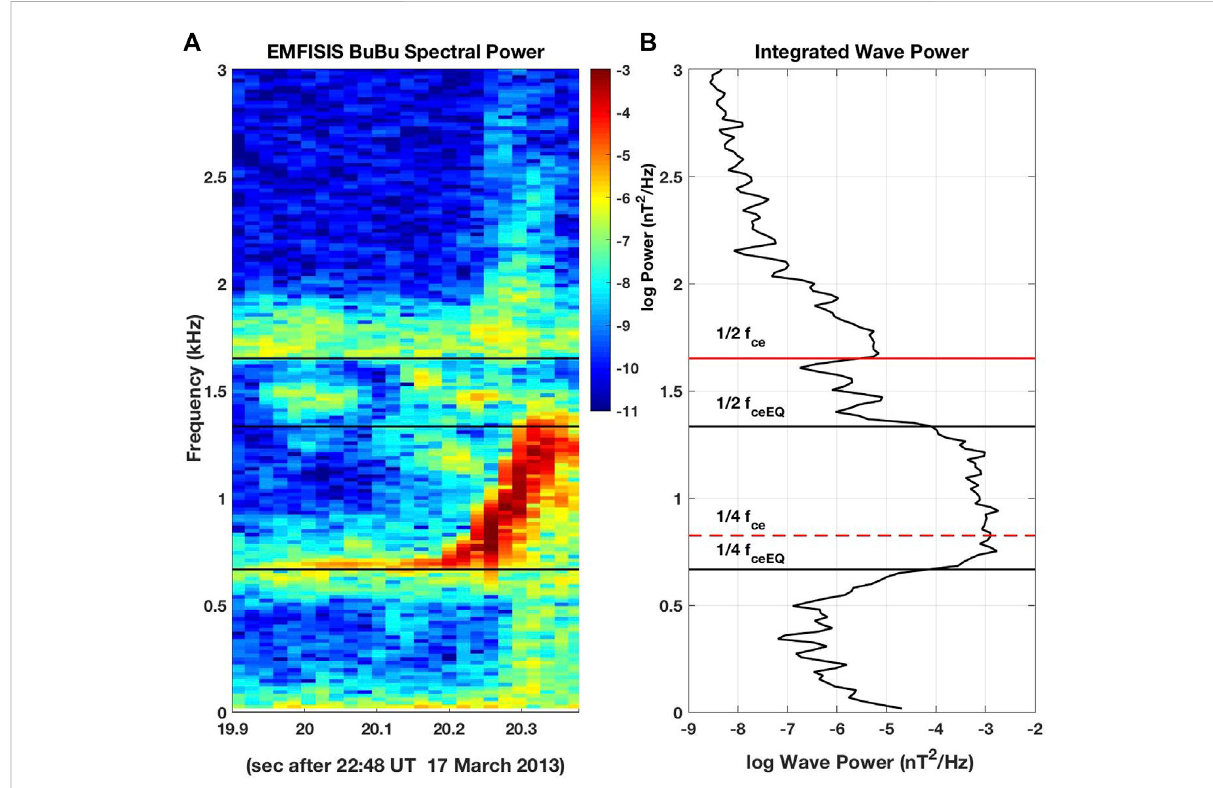
FIGURE 8 (A) The magnetic fi eld spectrogram observed near L = 6.5 by Van Allen Probe B at 22:48:20 UT on 17 March 2013 exhibited clear damping at frequencies below 1/2 the local electron cyclotron frequency (1/2 f ce ). (B) Integrated signal power at each frequency is shown for the ~400 ms of observations shown in (A) . The local value of f ce is observed at the spacecraft and the equatorial value of f ceEQ is determined from the characteristics of the damping of the chorus element (from Foster et al.